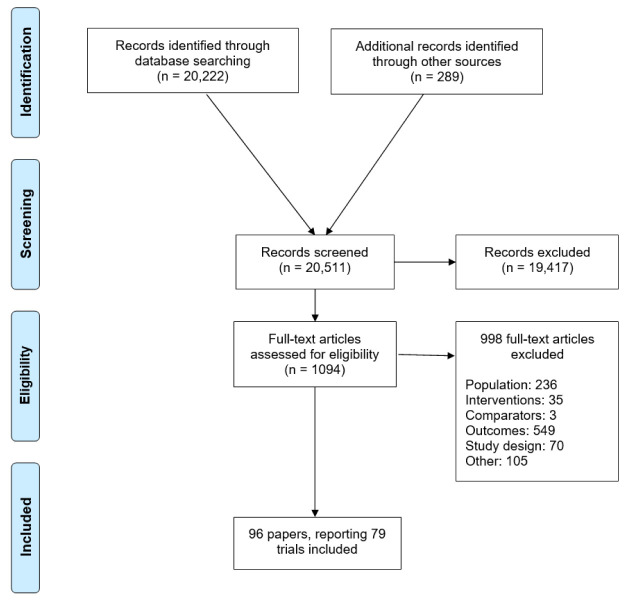
Study selection.